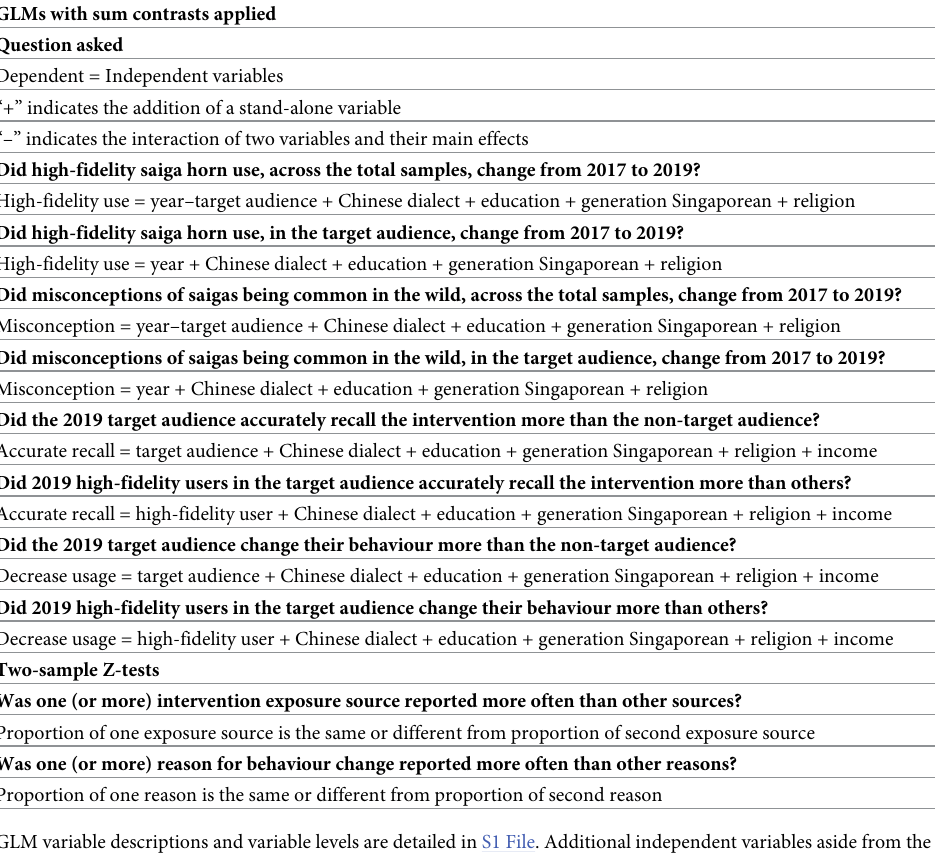
Table 1. Consumer survey analysis questions answered using statistical